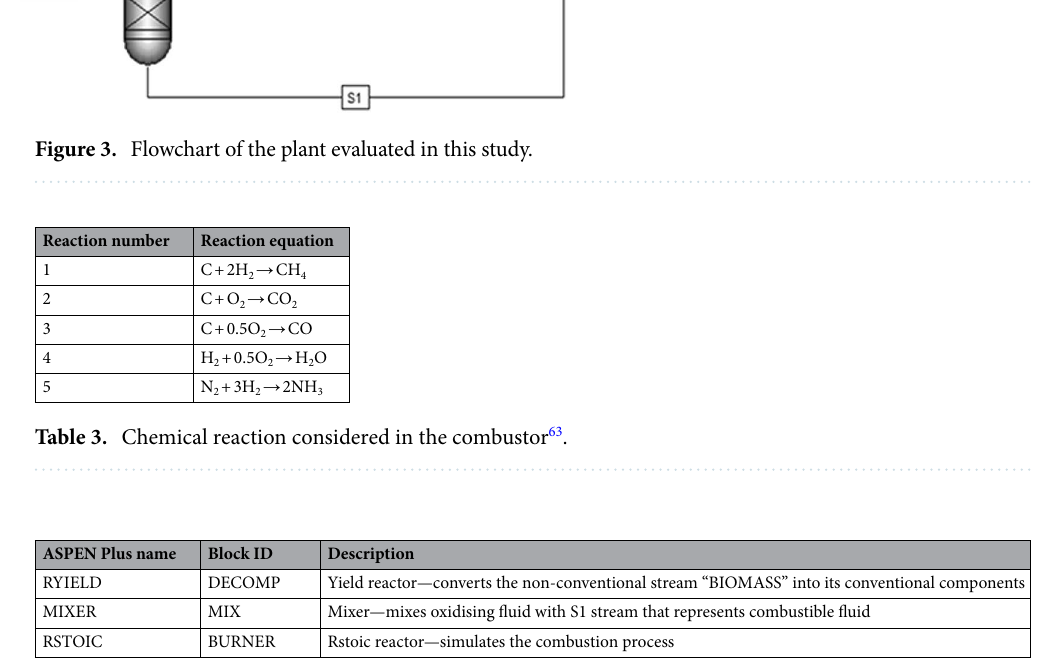
Table 4. Description of ASPEN Plus flowsheet unit operation presented in Fig.